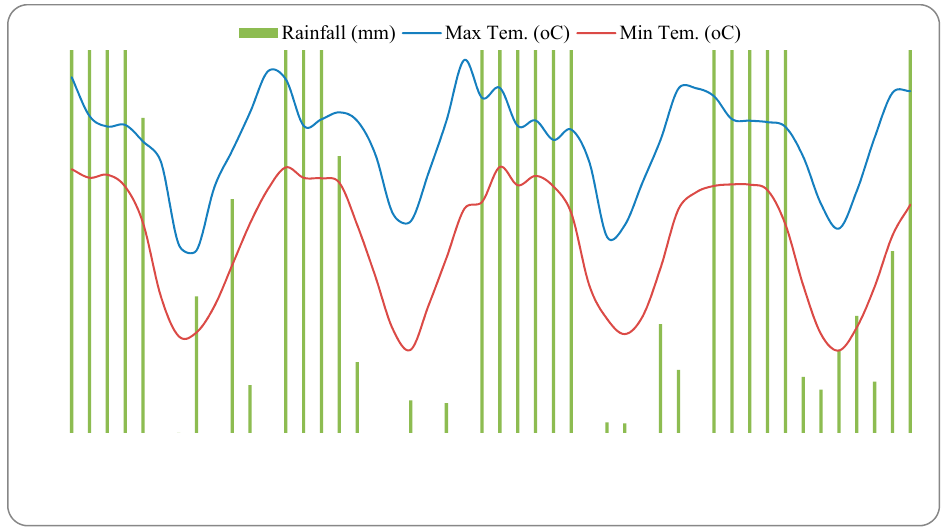
Figure 2. Mean monthly temperature (minimum and maximum) and total rainfall during a three year study period (2014 to 2017) and 35-years long term (1981–2015). Tem. Min.: Minimum Temperature; Tem. Max.: Maximum Temperature; LT-Long term (1981 to 2015).